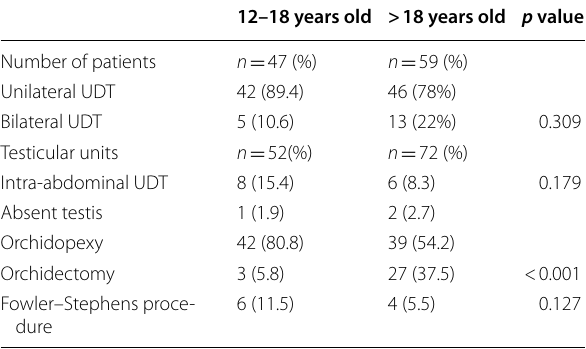
Table 3 Comparison between adolescent and post- pubertal patients, clinical findings and